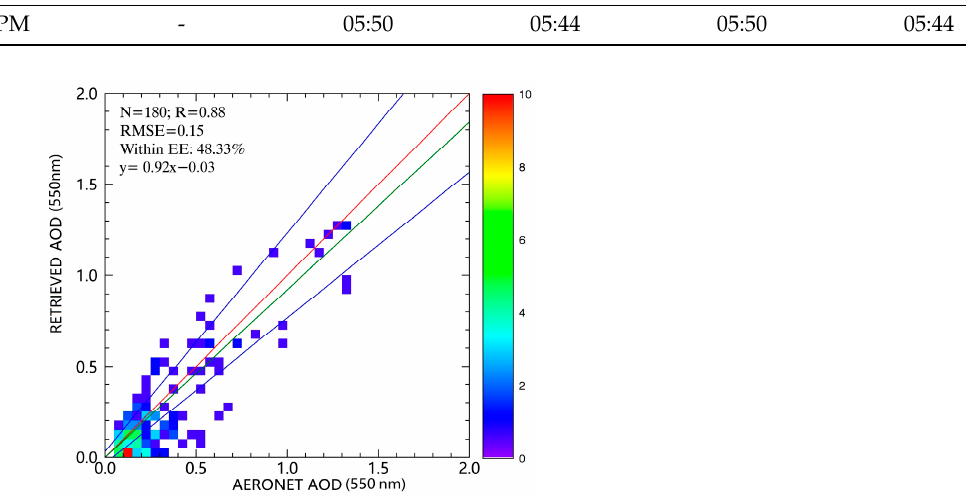
Figure 4. Comparison Between Retrieved AOD Using SRAP Algorithm and AOD Measured by AERONET Stations.